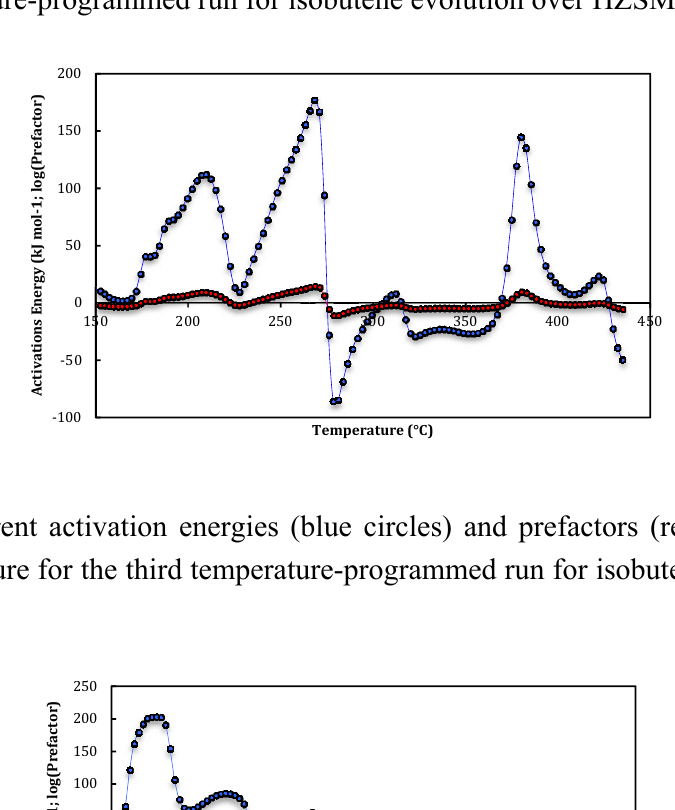
Figure 2. Apparent activation energies (blue circles) and prefactors (red circles) for the second temperature-programmed run for isobutene evolution over HZSM-5.